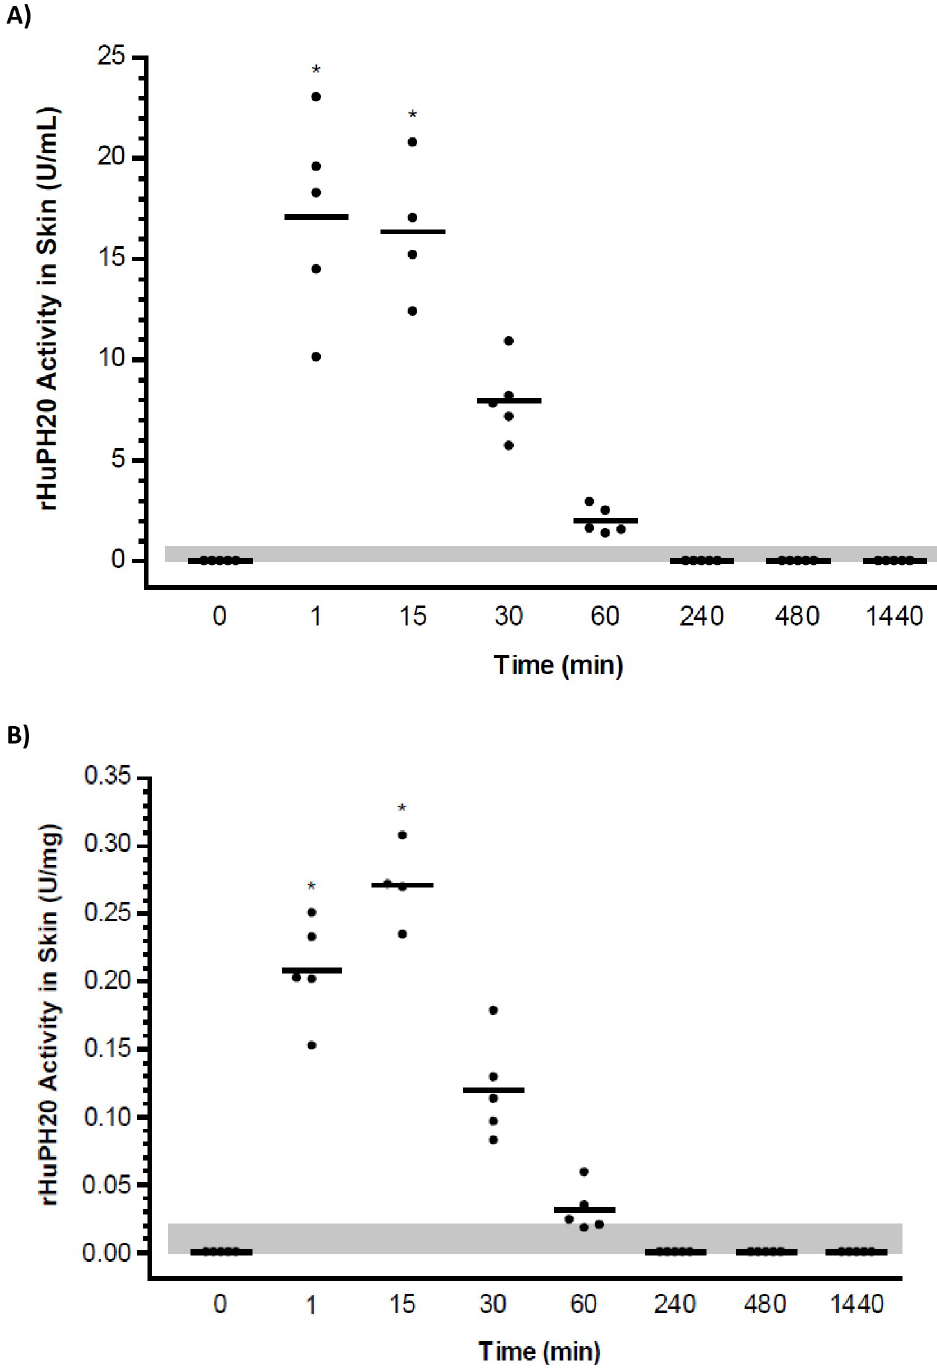
Fig 1. Biodistribution study: Concentration-time course of rHuPH20 in skin samples after ID delivery. rHuPH20 concentration in skin samples from individual animals (circles) are depicted as well as the mean (line) for each time point. (A) Concentration in U/mL, LLOQ = 0.70 U/mL. (B) Concentration in U/mg wet tissue weight, LLOQ = 0.02 U/mg, � P < 0.05; two-tailed t-test; samples beyond 15 minutes compared with samples at 1 and 15 minutes. Values lower than the LLOQ (shaded area) are plotted as 0. LOQ, lower limit of quantitation; rHuPH20, recombinant human hyaluronidase PH20.